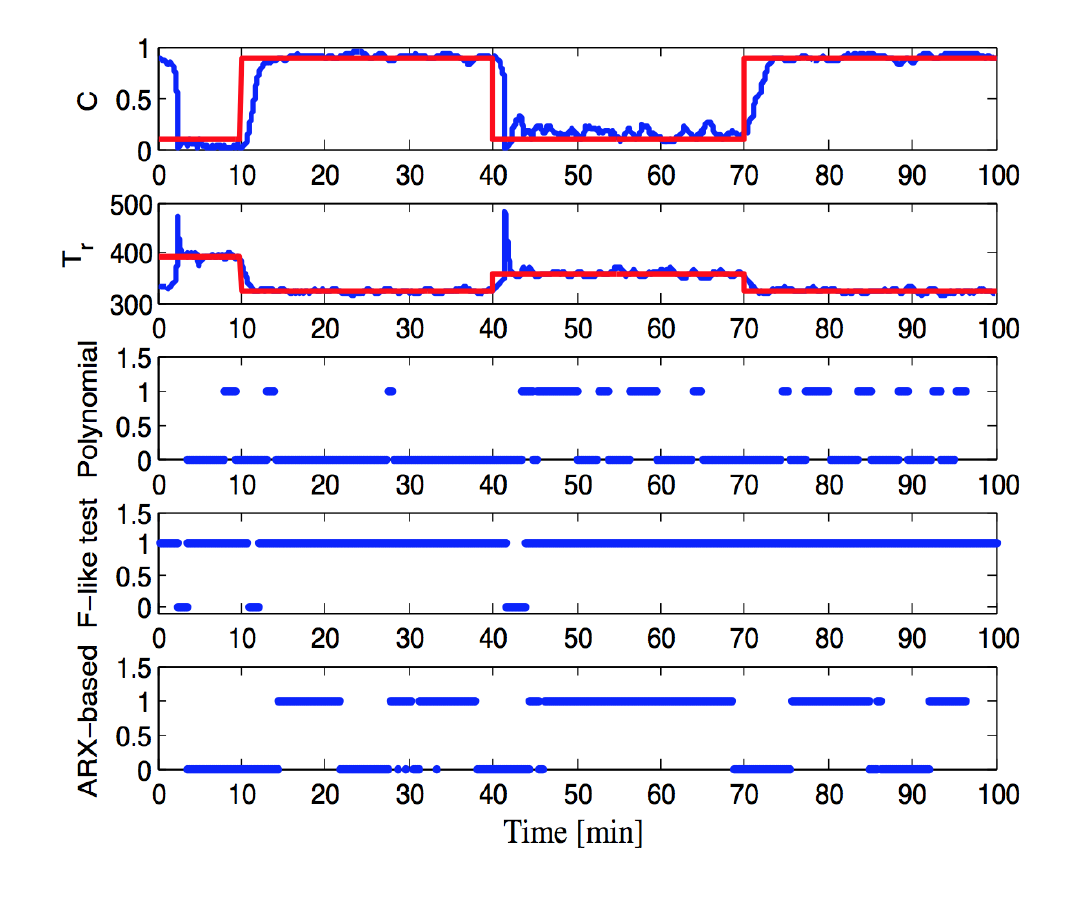
Figure 4. CSTR data results with 3% of noise, in which a window of 70 was used for